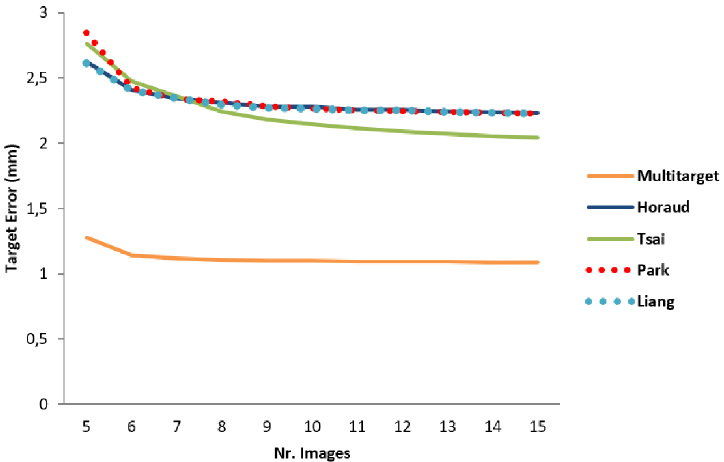
Fig 11. Target registration error trend at the scanning depth of 7.4 cm. The Multi-target (orange line) showed the lowest TRE of all 3D mode calibration methods. By adding more calibration images, the error did not improve markedly. With the Hand-eye method, the error decreased for the first five image samples but it was generally higher compared to the Multi-target method.